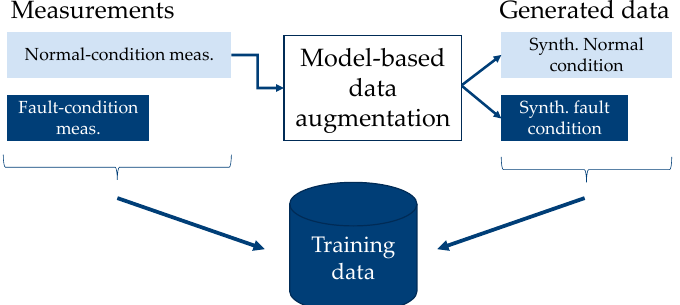
Figure 3. Generation of synthetic data and constellation of the training data when synthetic normal- and abnormal-condition data are used to augment the training data [29].